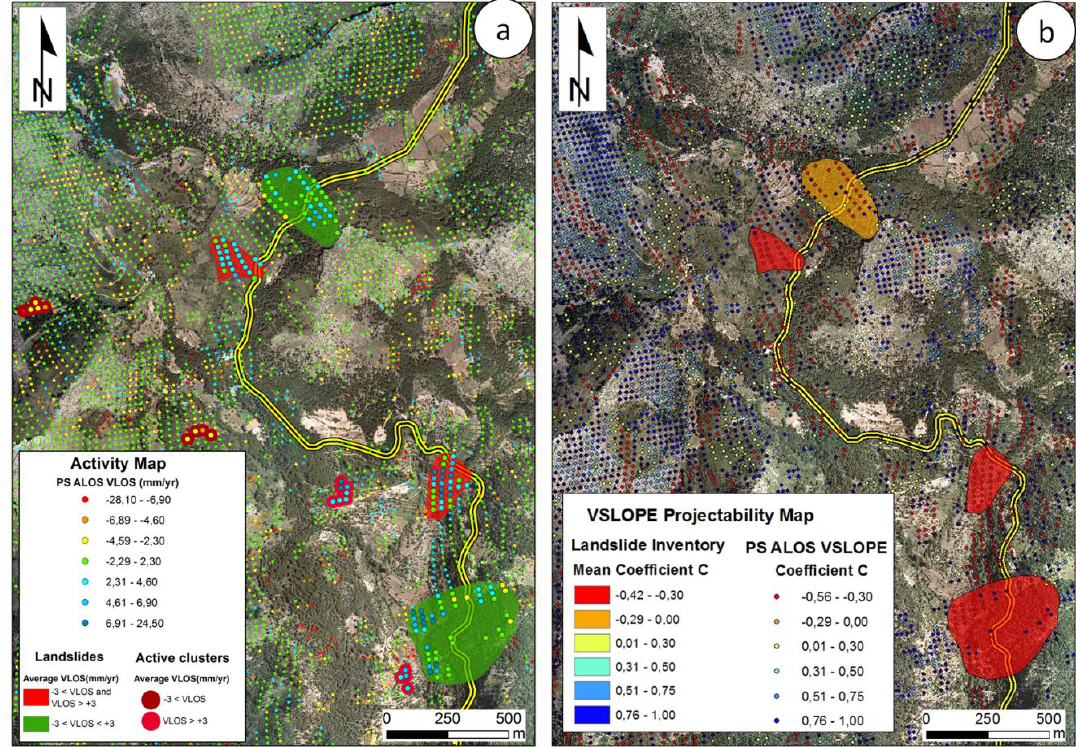
Figure 8. Landslide activity maps: ( a ) Average V based on C Coefficient.